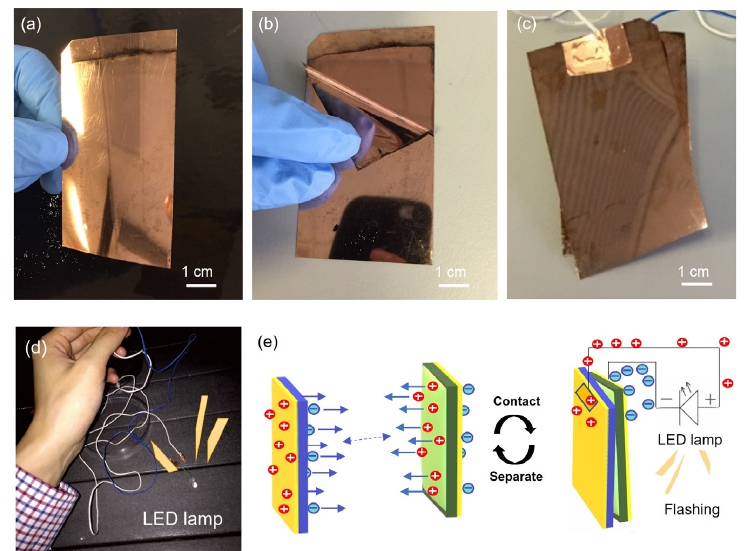
Figure 2. Photographs showing the two triboelectric layers originally bonded together ( a ) before separation, ( b ) during separation, and ( c ) after separation. The outer surface of the two triboelectric layers, i.e., the PET and PE layers, was coated with a uniform and highly adhesive thin copper film produced by a chemical process. ( d ) Photograph showing an illuminated LED lamp powered by a flexible and robust TENG. ( e ) Schematic of the mechanism behind the flexible TENG, which can be used to power an LED lamp.